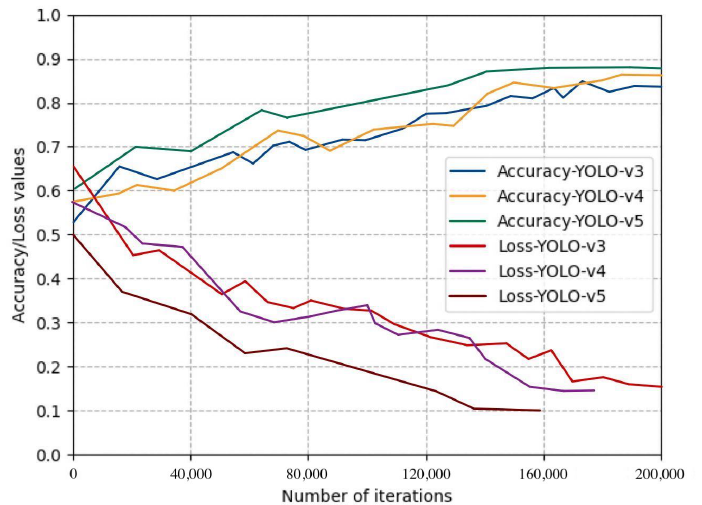
Figure 9. Training curves of accuracy and loss against number of iterations on YOLO series.